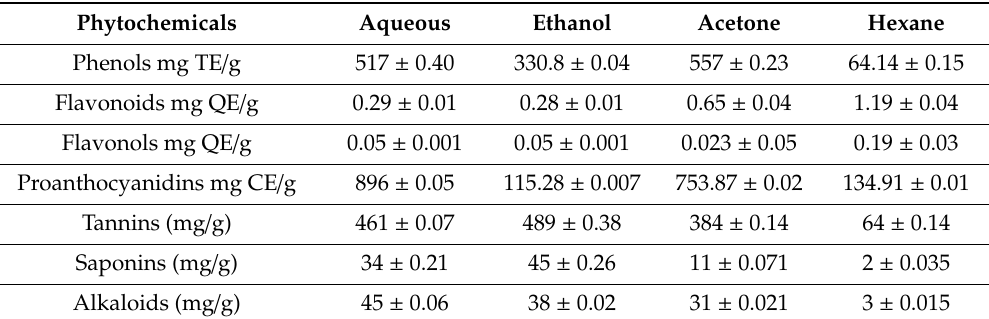
Table 2. Evaluation of the quantities of phytochemicals in the leaf extract of Carpobrotus edulis. Data were obtained in triplicate and presented as mean ± standard deviation